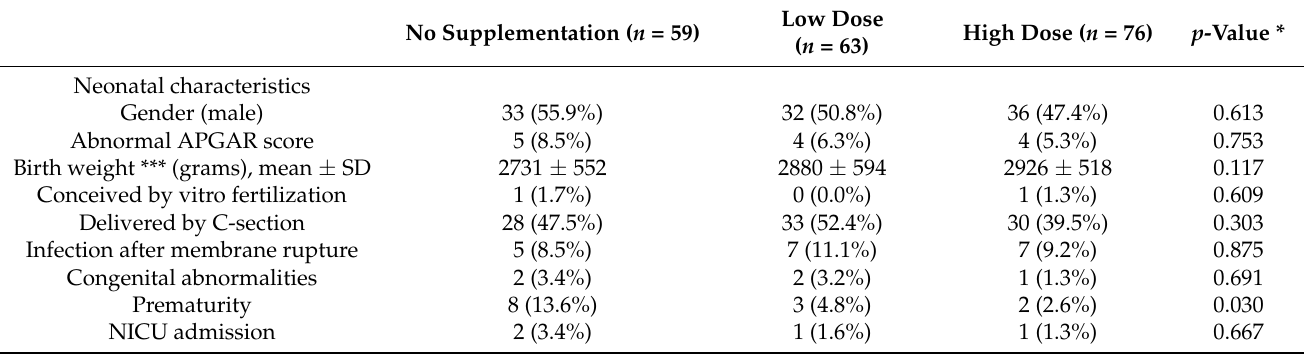
Table 3. Neonatal characteristics are stratified by maternal vitamin D oral supplementation during